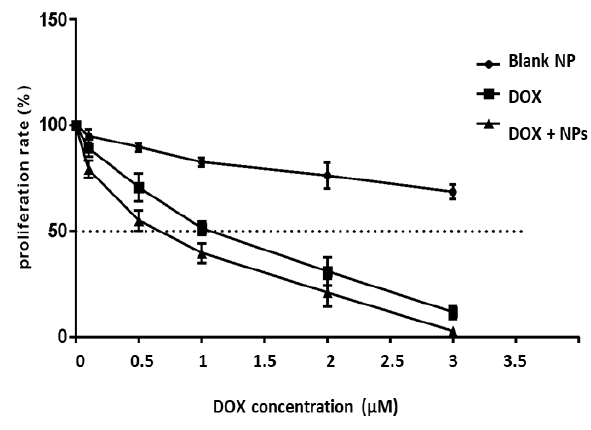
Figure 4: Proliferation rate as a percentage of the control. MCF-7 cells were exposed to varying concentrations of free DOX (DOX), DOX-nanocarrier (DOX + NPs), or free nanocarrier (Blank